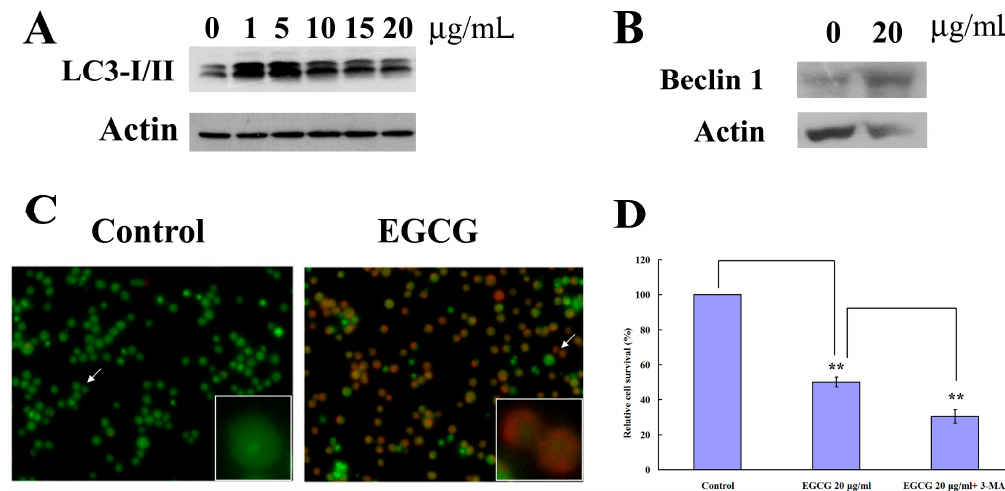
Figure 3. EGCG induced autophagy in PEL cells. ( A ) Western blot analysis to detect LC3-I/II expression in EGCG-treated BCBL-1 cells; ( B ) Western blot analysis to detect Beclin expression in EGCG-treated BCBL-1 cells; ( C ) EGCG induced formation of acidic vesicular organelles in PEL cells; ( D ) Effects of autophagy inhibitor (3-MA) on the cell viability of EGCG-treated BCBL-1 cells. The representative data are shown. The results are the means of three independent experiments, and bars represent the standard errors. ** p < 0.01 indicates significant differences between the control and EGCG-treated cells, or significant differences between the cells treated with EGCG and the cells cotreated with EGCG and 3-MA.